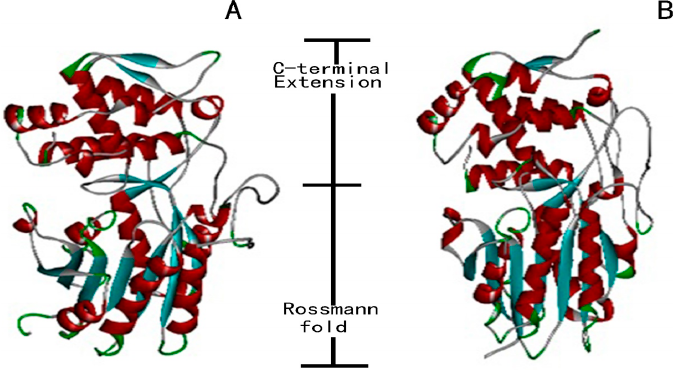
Figure 3. Predicted three-dimensional homology structure of SmIS1 ( A ) and SmIS2 ( B ) using recombinant CrIS from C. roseus (5COB) as a template. Helices and sheets are represented in red and blue, respectively. their homologues in other plants (Figure 4). All of the compared species belonged to the P5 β Rs group. SmIS2 belonged to one subclade that clustered with C. roseus P5bR4 (AIW09146.1), O. europaea